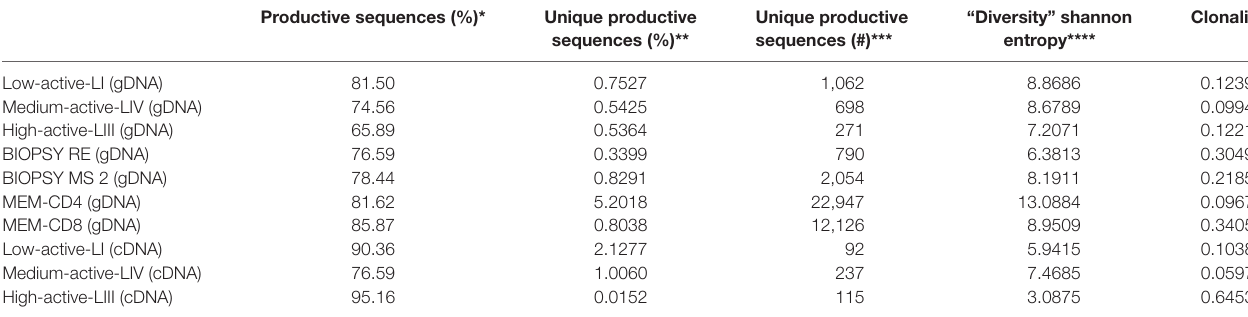
TaBle 1 | Summary of TRBV sequence information.